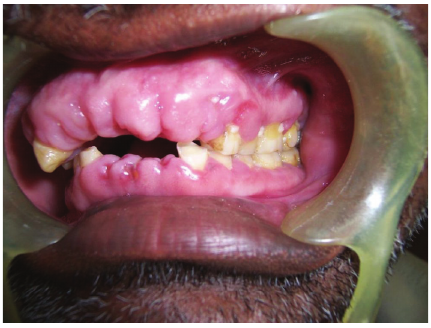
Figure 3: Showing response to therapy after 1.5